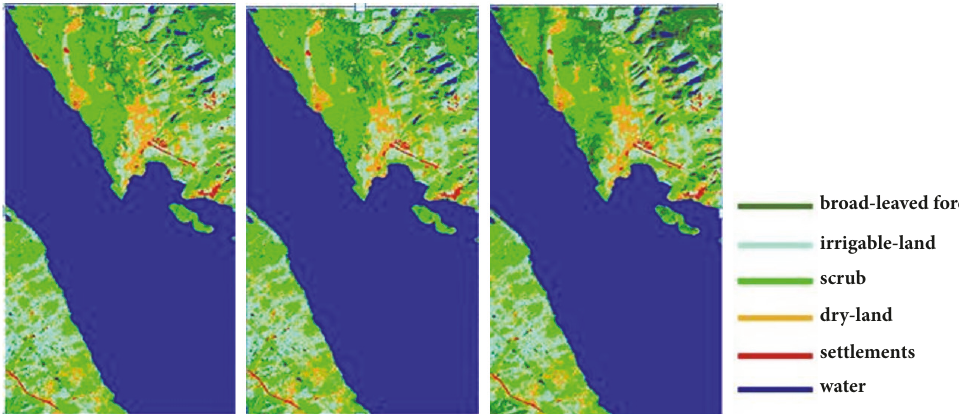
Figure 19: The classification results of minimum distance algorithm for the Hyperion